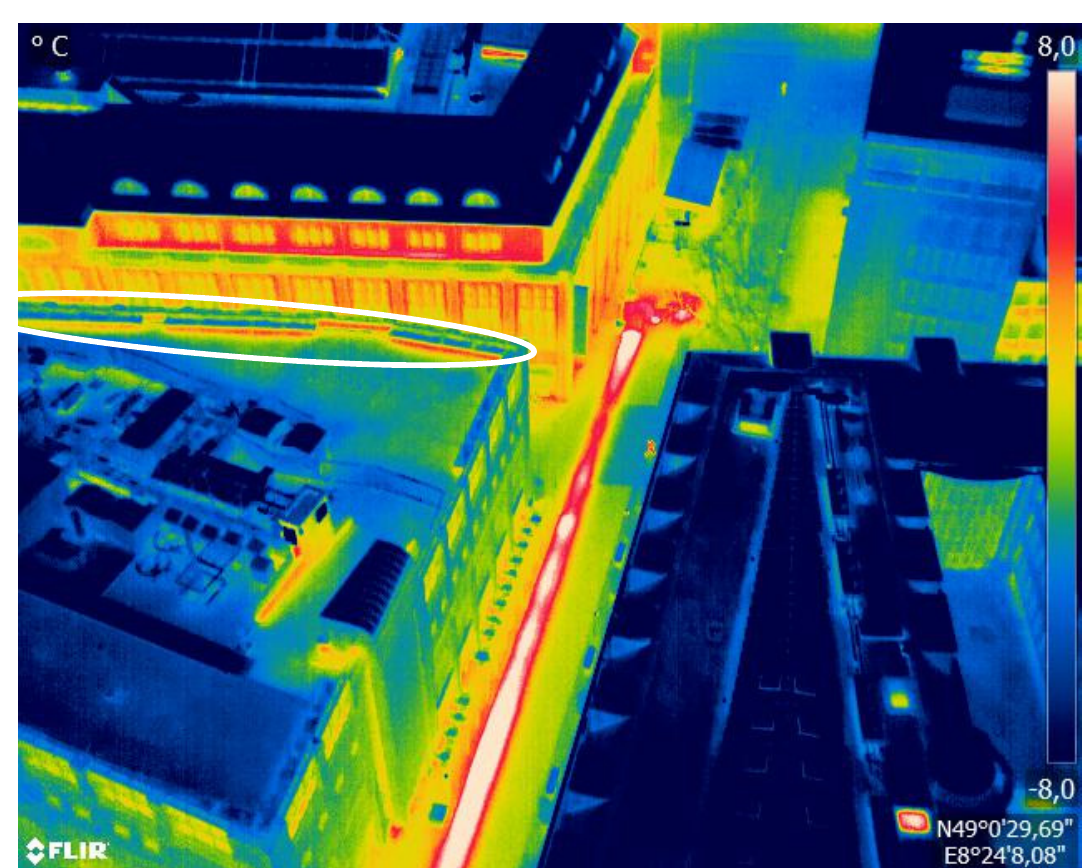
Figure A19. Example: thermal bridge of an attic.